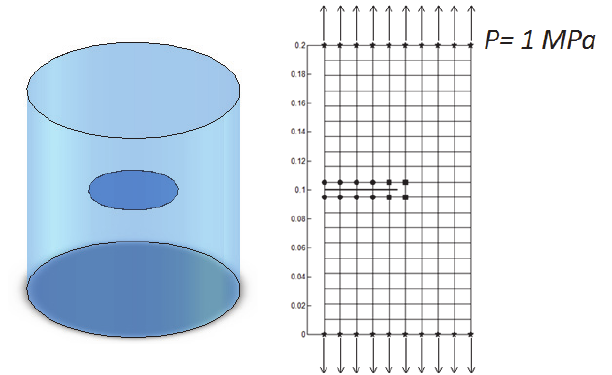
Figure 3: (a) Schematic plot of a transparent circular solid cylinder with central Penny-shaped crack. (b) A finite element mesh for an axisymmetric cross section used in the XFEM models.